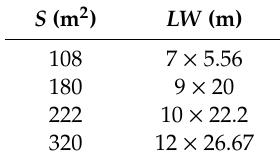
Table 3. The values of L and W in each